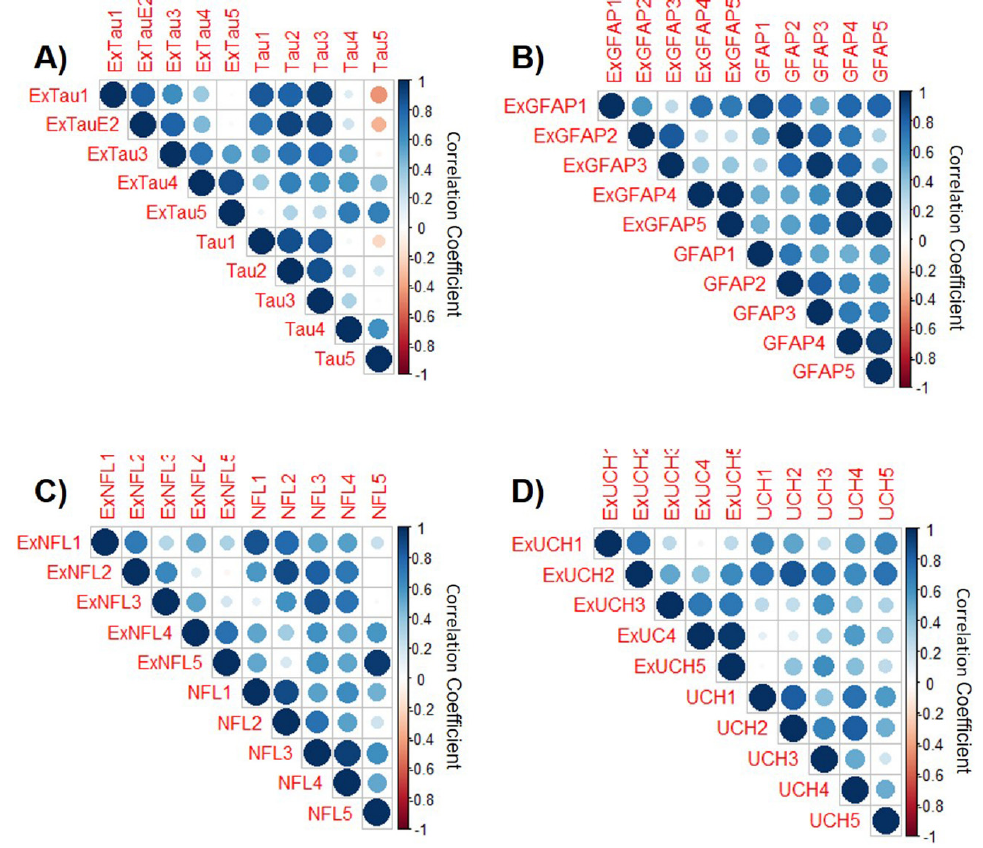
Figure 3. Correlation plots displaying associations between serum and exosomal ( A ) t-tau, ( B ) GFAP, ( C ) NFL, and ( D ) UCH-L1 concentration over the study. Positive correlations are displayed in blue and negative correlations in red. Color intensity and the size of the circle are indicative of the strength of correlation. In the right side of the correlogram, the legend color shows the correlation coefficients and the corresponding colors.